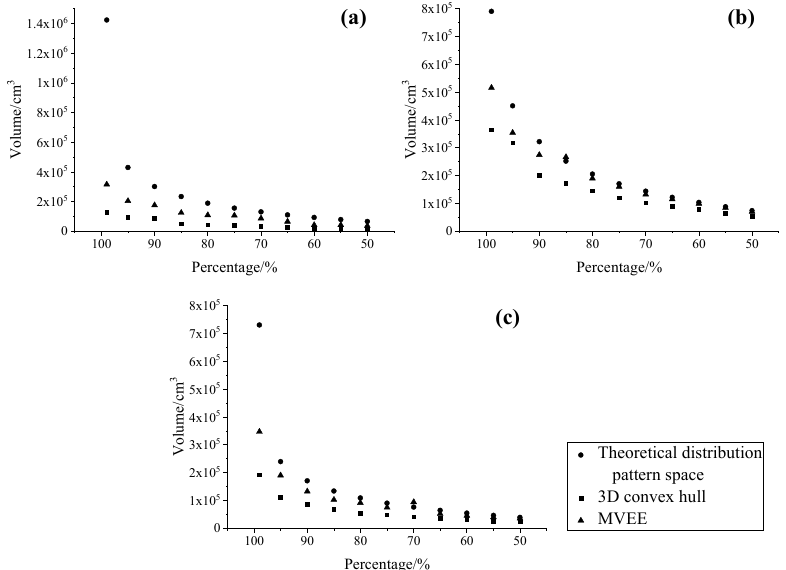
Figure 7. Volume evaluation of three methods. ( a ) Volume evaluation of Specimen S2. ( b ) Volume evaluation of Specimen S3. ( c ) Volume evaluation of Specimen S5.